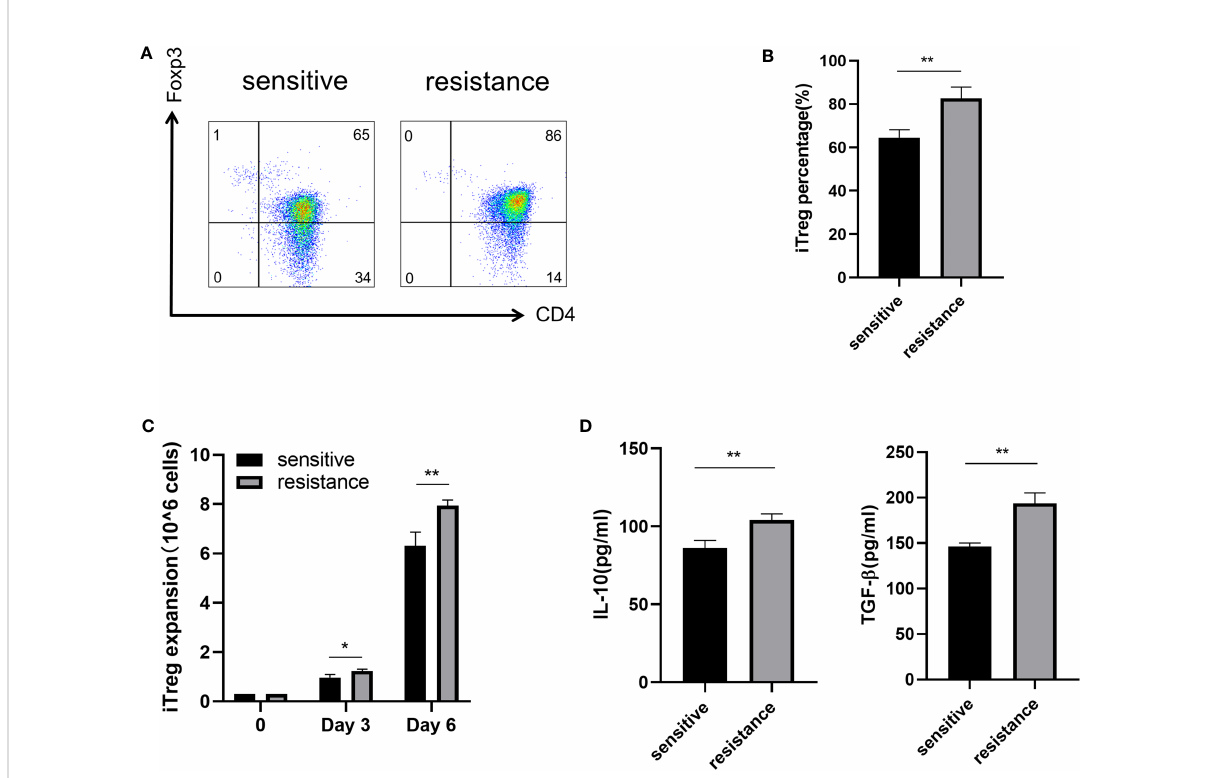
FIGURE 3 Induction of iTregs by lactate in the resistance group. Representative fl ow plot (A) for and the frequency (B) of Foxp3 expression in iTregs with the addition of lactate (10 mM) from sensitive and resistant patients. (C) The expansion ability of iTregs. (D) The expression of anti-in fl ammatory cytokines including IL-10 and TGF- b from the serum was evaluated through ELISA. The bar shows the mean ± SEM of the levels of indicated proteins. (sensitive patients n=4; resistant patients n=4). *p < 0.05; **p <